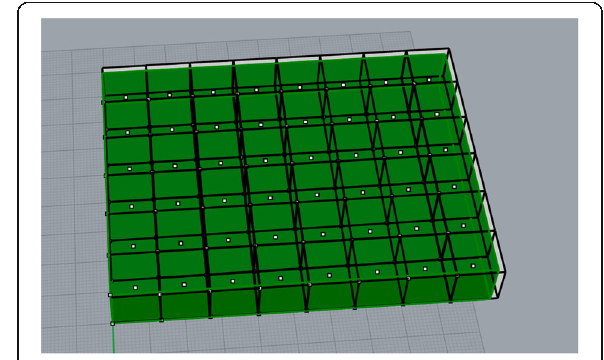
Fig. 6 Node deployment simplifies